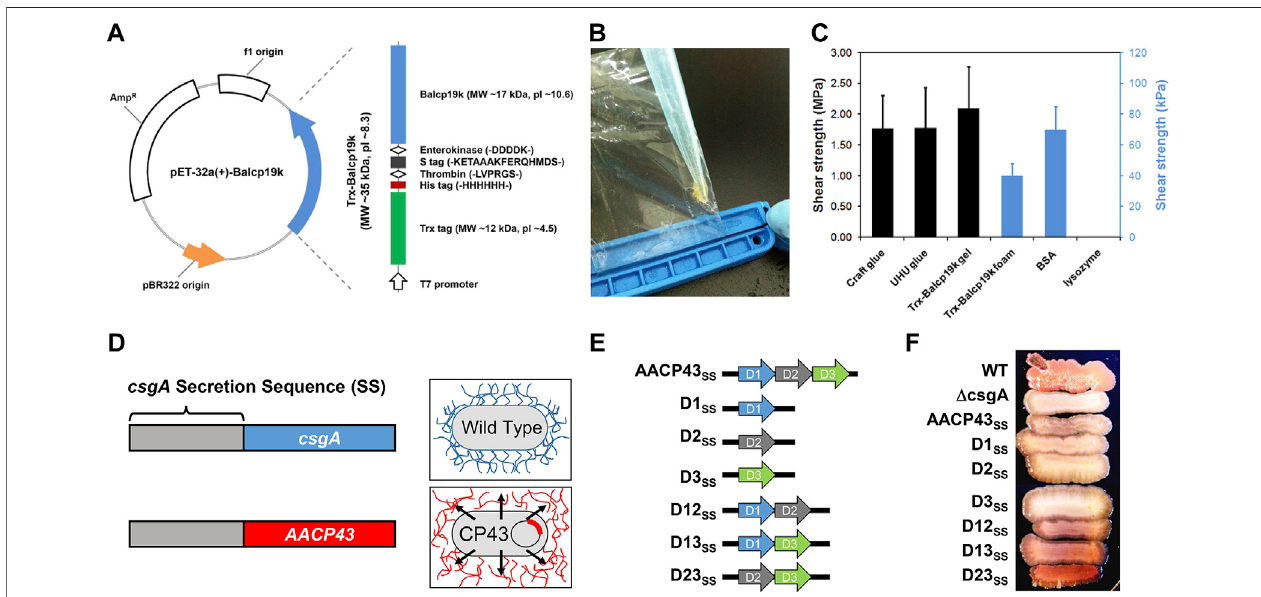
FIGURE 3 | Expression and characterization of different recombinant BCPs. (A) Structural illustration of Trx-Balcp19k. (B) Photograph of the tacky condensates (Trx-Balcp19k gel) formed by Trx-Balcp19k after being dialyzed against pure water. (C) Adhesive shear strength of different samples. Craft glue and UHU glue are commercially available chemical adhesives, and the Trx-Balcp19k foam represents unaggregated Trx-Balcp19k. (D) Scheme showing the design concept of AACP43 SS . (E) Structural illustrations of AACP43 SS and its mutants. (F) Congo red staining results of wild-type (WT) bacterial strains, Δ csgA, and Δ csgA expressing AACP43 SS and its mutants. (A – C) Adapted from Liang et al. (2015). (D – F) Adapted with permission from Estrella et al. (2021). Copyright 2021, American Chemical